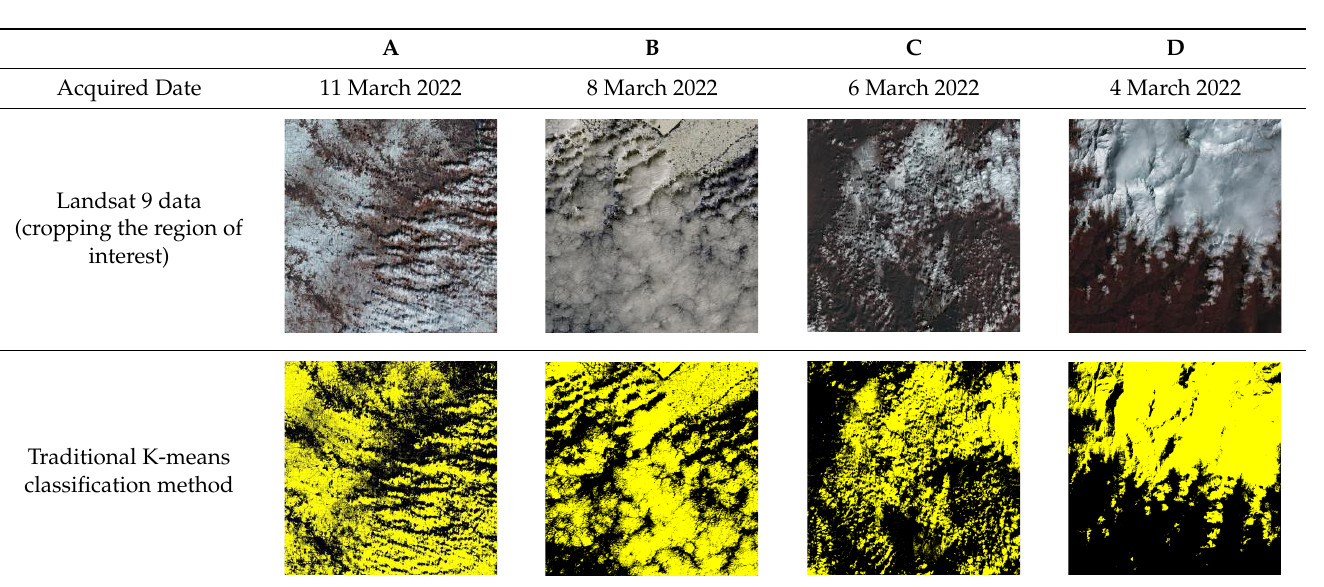
Table 2. Landsat 9 images with complex background information of the study area (A-D correspond to the four data selected in this paper, respectively. Cropping the region of interest), with the (i) acquired date, (ii) original images, (iii) cloud screening results using the traditional K-means unsupervised classification method.